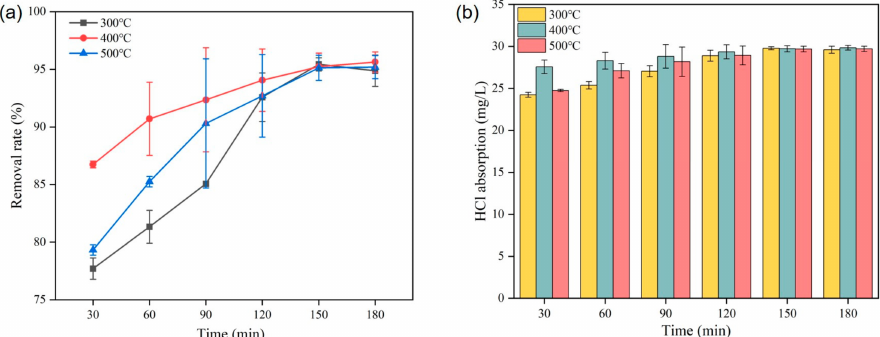
Figure 1. Effect of different temperatures on ( a ) HCl removal rate (%) and ( b ) HCl adsorption